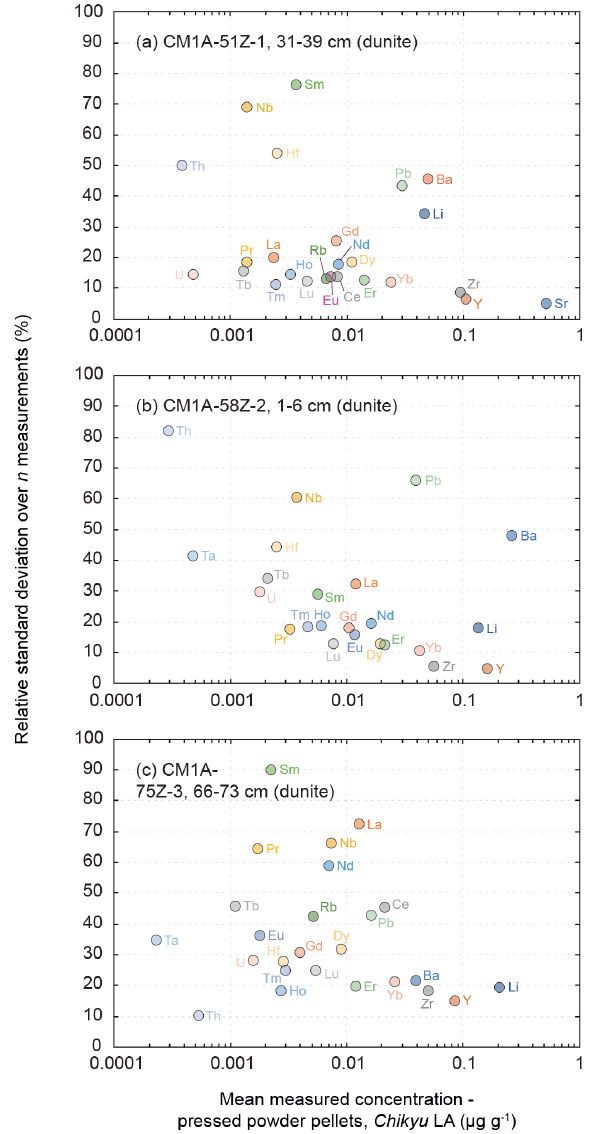
Figure 10. Evolution of the relative standard deviation (RSD, in %) relative to the measured element concentrations for the three dunite samples from the Hole CM1A (a) CM1A-51Z-1, 31–39cm ( n = 6), (b) CM1A-58Z-2, 1–6cm ( n = 6), and (c) CM1A-75Z-3, 66–73cm ( n =